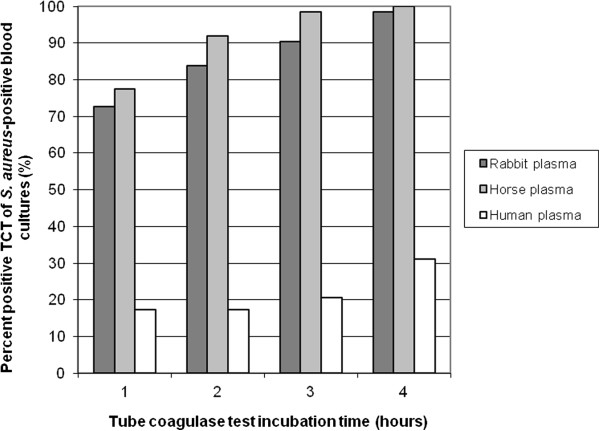
The sensitivity of the tube coagulase tests (TCT) for S. aureus varies with plasma species used in the test. Twelve S. aureus strains were inoculated in previously negative blood culture bottles, incubated and when signalling positive subjected to tube coagulase test (TCT) by addition of 75 μL material from inoculated blood cultures bottles positive for S. aureus to 0.5 mL plasma of three species; rabbit (n = 62), horse (n = 62) and human (n = 29). The tubes were incubated at 36°C and observed for coagulation every 15 minutes during the first four hours and then after 24 hours of incubation. The figure shows the amount of positive tests within the different time intervals in percent of total bottles incubated with S. aureus.